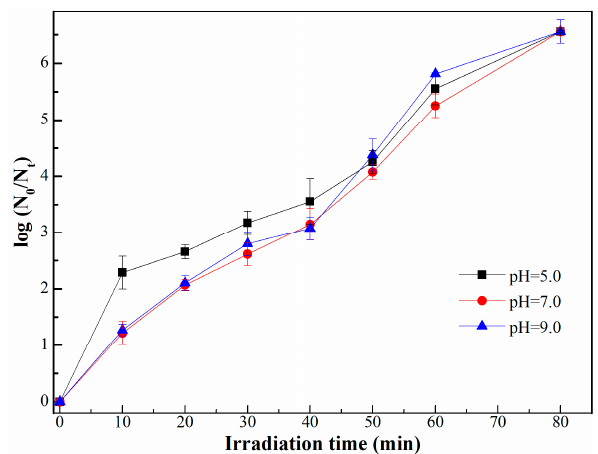
Figure 7. Effect of pH on the photocatalytic removal efficiency of bacteriophage